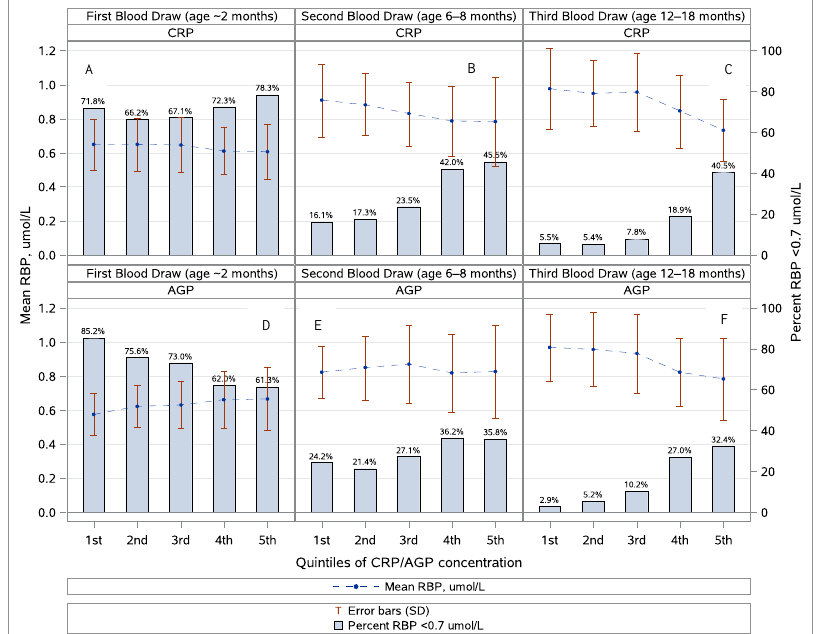
Figure 1. Prevalence of infant vitamin A deficiency (VAD; RBP < 0.70 µ mol/L) and mean RBP by quintiles of the C-reactive protein (CRP) and the alpha(1)-acid glycoprotein (AGP) and by blood draw. Panels ( A – C ) show VAD by CRP quintiles for blood drawn at ~2, 6–8, and 12–18 months, respectively. Panels ( D – F ) show VAD by AGP quintiles for the same time periods. The prevalence of VAD was not significantly different (Cochran Armitage trend test, p = 0.23) by CRP quintile for infants measured at the first blood draw (~2 months of age, panel ( A )) even though VAD seemed to decrease slightly by the AGP quintile at the first blood draw (Cochran Armitage trend test, p = 0.0001, panel ( D )). However, prevalence of VAD significantly increased by CRP and AGP quintile for infants at the second and third blood draws (6–8 and 12–18 months of